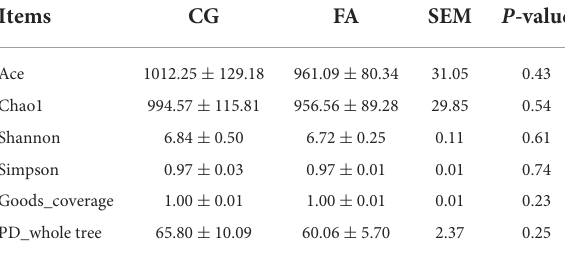
TABLE 4 Alpha diversity indexes of cecal